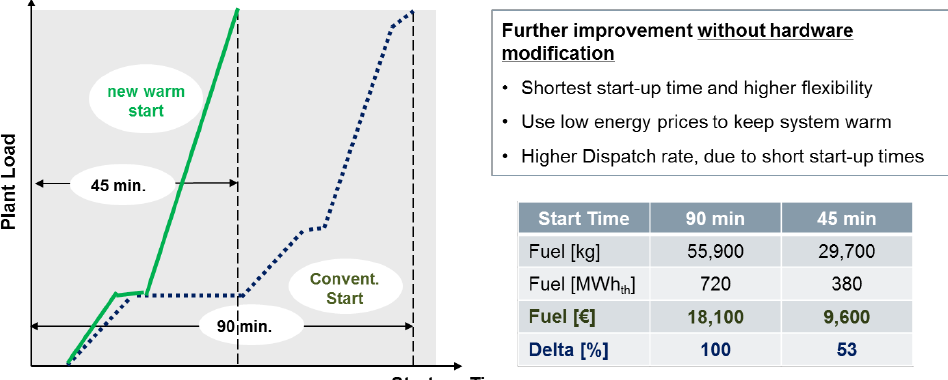
Figure 11. Warm Co-Start Test at Lausward CHP